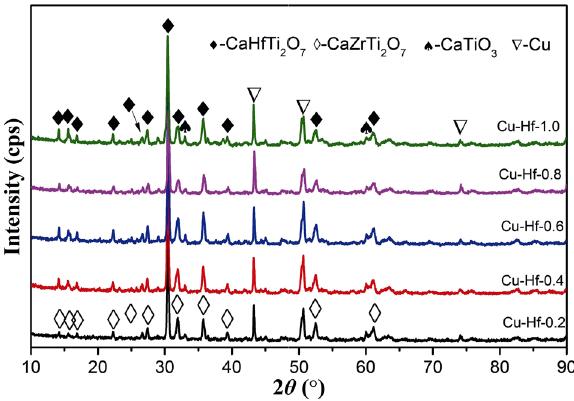
Fig. 3 XRD patterns of the Hf-doped samples with x value of 0.2–1.0.